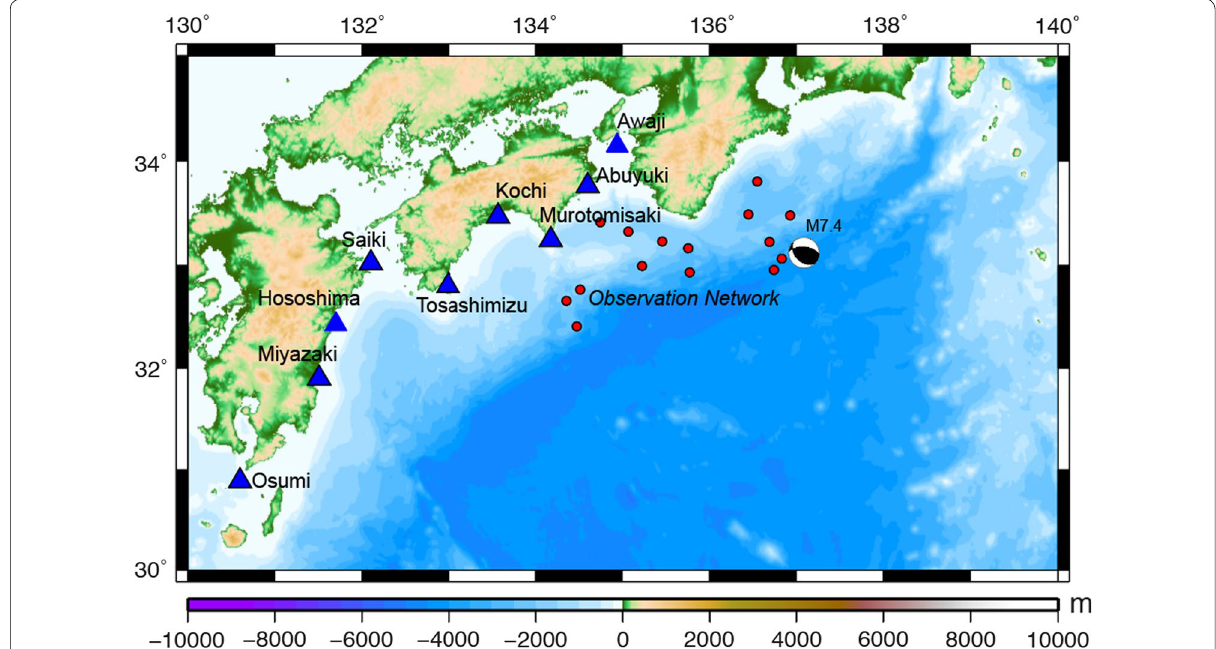
Fig. 1 The observation network for data assimilation and near-shore PoIs. The observation points contain 13 DONET stations, PG1 and PG2, which are marked with red circles. Nine PoIs near Shikoku Island and Kyushu Island are marked with blue triangles. The focal mechanism is plotted according to Yamanaka